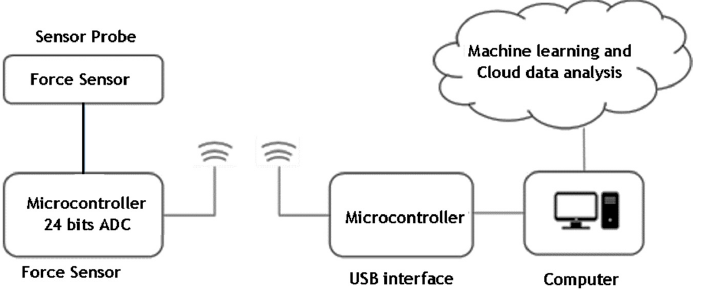
Figure 3. System architecture.